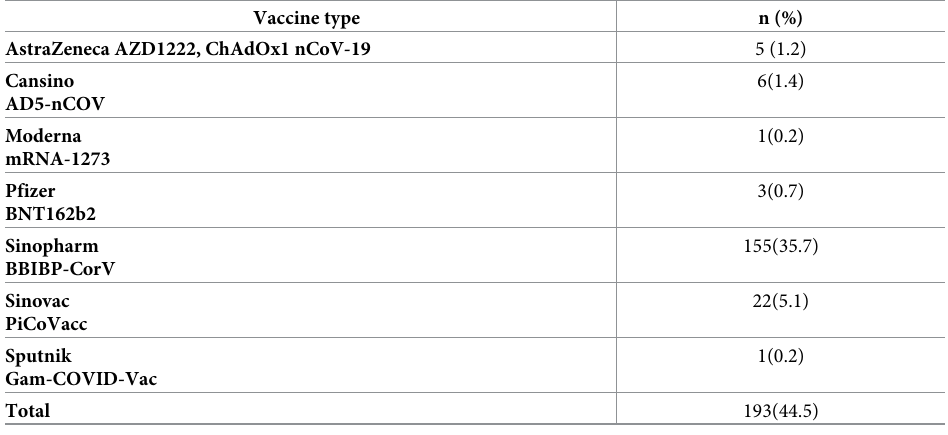
Table 2. Type of Vaccination received by study